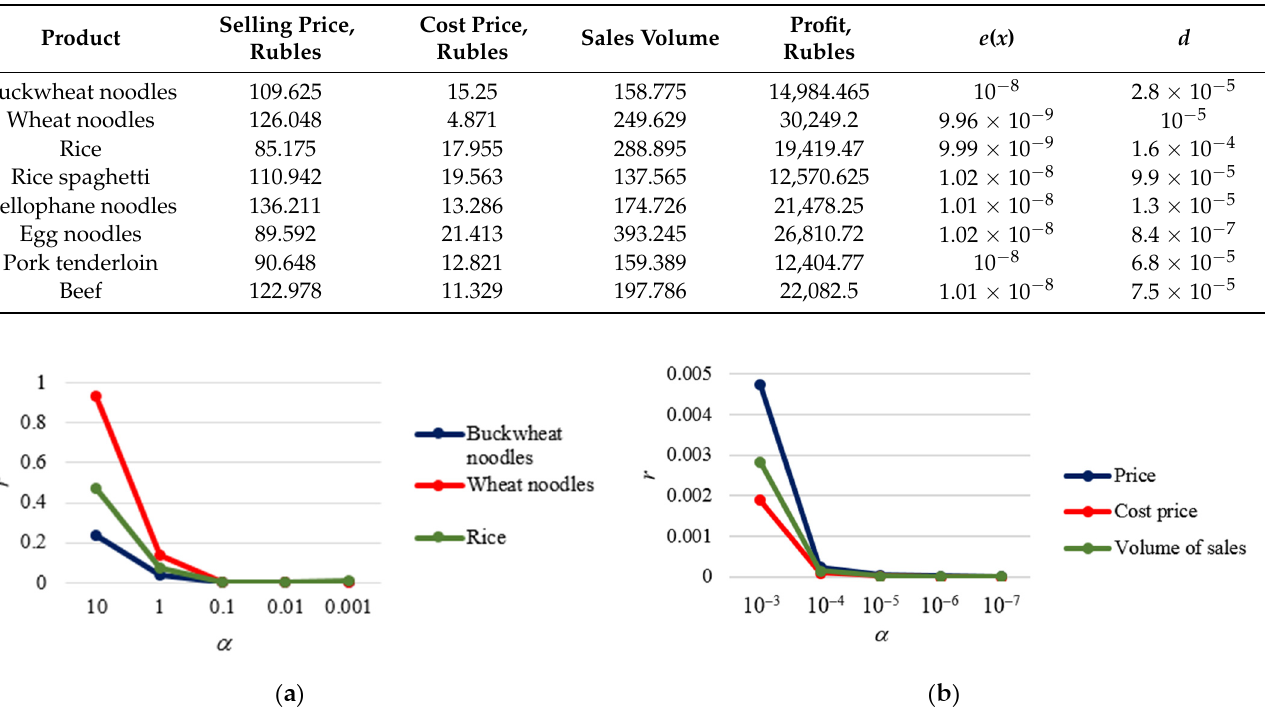
Figure 12. Dependence of difference d on parameter α : ( a ) first level; ( b ) second level.